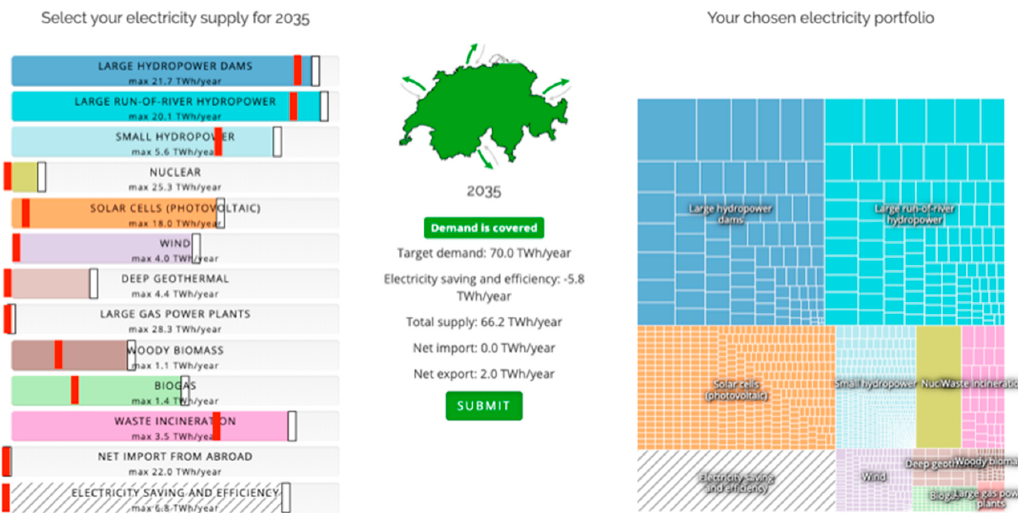
Figure 6. Average preferred Swiss electricity mixes of the informed citizen panel using the interactive tool Riskmeter [52]. The red lines indicate the minimum amount that the participants could use for each technology (because these technologies are already built in Switzerland and will remain in 2035).